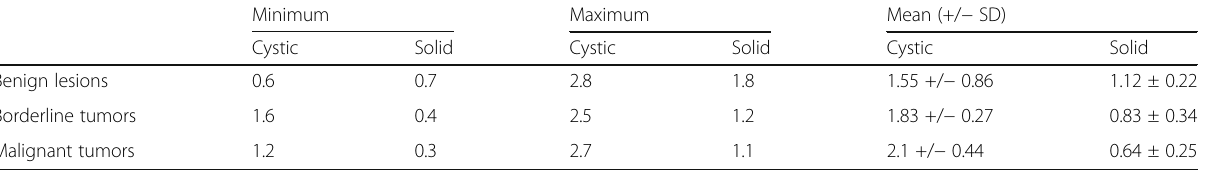
Table 5 The ADC values of both the cystic/ solid components of the adnexal lesions